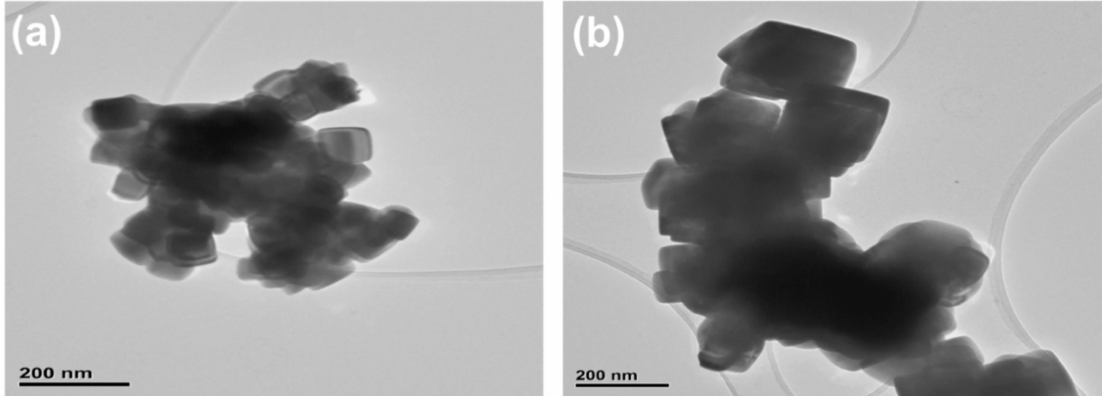
Figure 4. TEM analysis of PbSe samples prepared at ( a ) 400 ◦ C; ( b ) 450 ◦